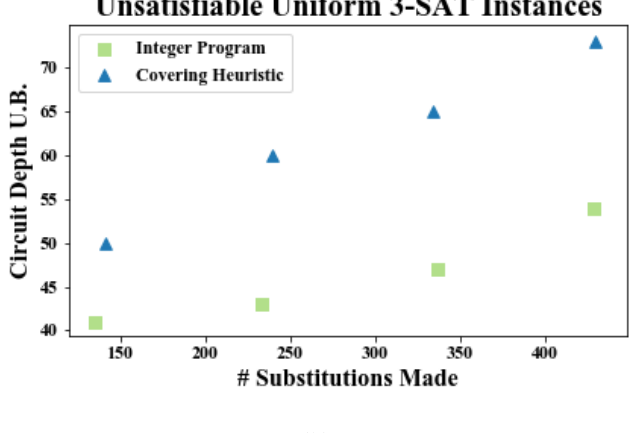
Figure 8. Plots of the upper bound of the maximum degree of the derived graph versus the number of substitutions made for the uniform 3-SAT instances found in Table 3. The satisfiable instances C C plotted are denoted ’uf n - ’. The unsatisfiable instances are denoted ’uuf n - ’. These instance | | | | names indicate the number of literals n and clauses C in each problem instance. We choose the upper bound of the maximum degree to be the y-axis since the largest unitary circuit depth for one iteration is the maximum degree plus two. Calculating the exact unitary depth requires finding the edge chromatic number of each graph, which is NP-hard, and results in a number that differs from the upper bound by at most one. ( a ) Plot of the maximum degree of the derived graph versus the number of substitutions made for the satisfiable uniform 3-SAT instances in Table 3. ( b ) Plot of the maximum degree of the derived graph versus the number of substitutions made for the unsatisfiable uniform 3-SAT instances found in Table